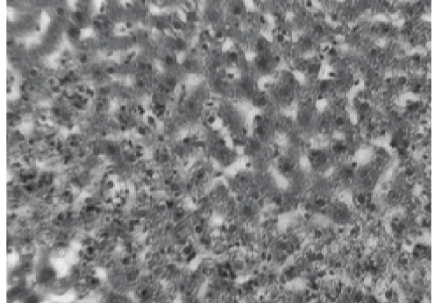
Figure 1: Liver section in control animals showing normal paren- chymal cells with granulated cytoplasm and normal architecture.